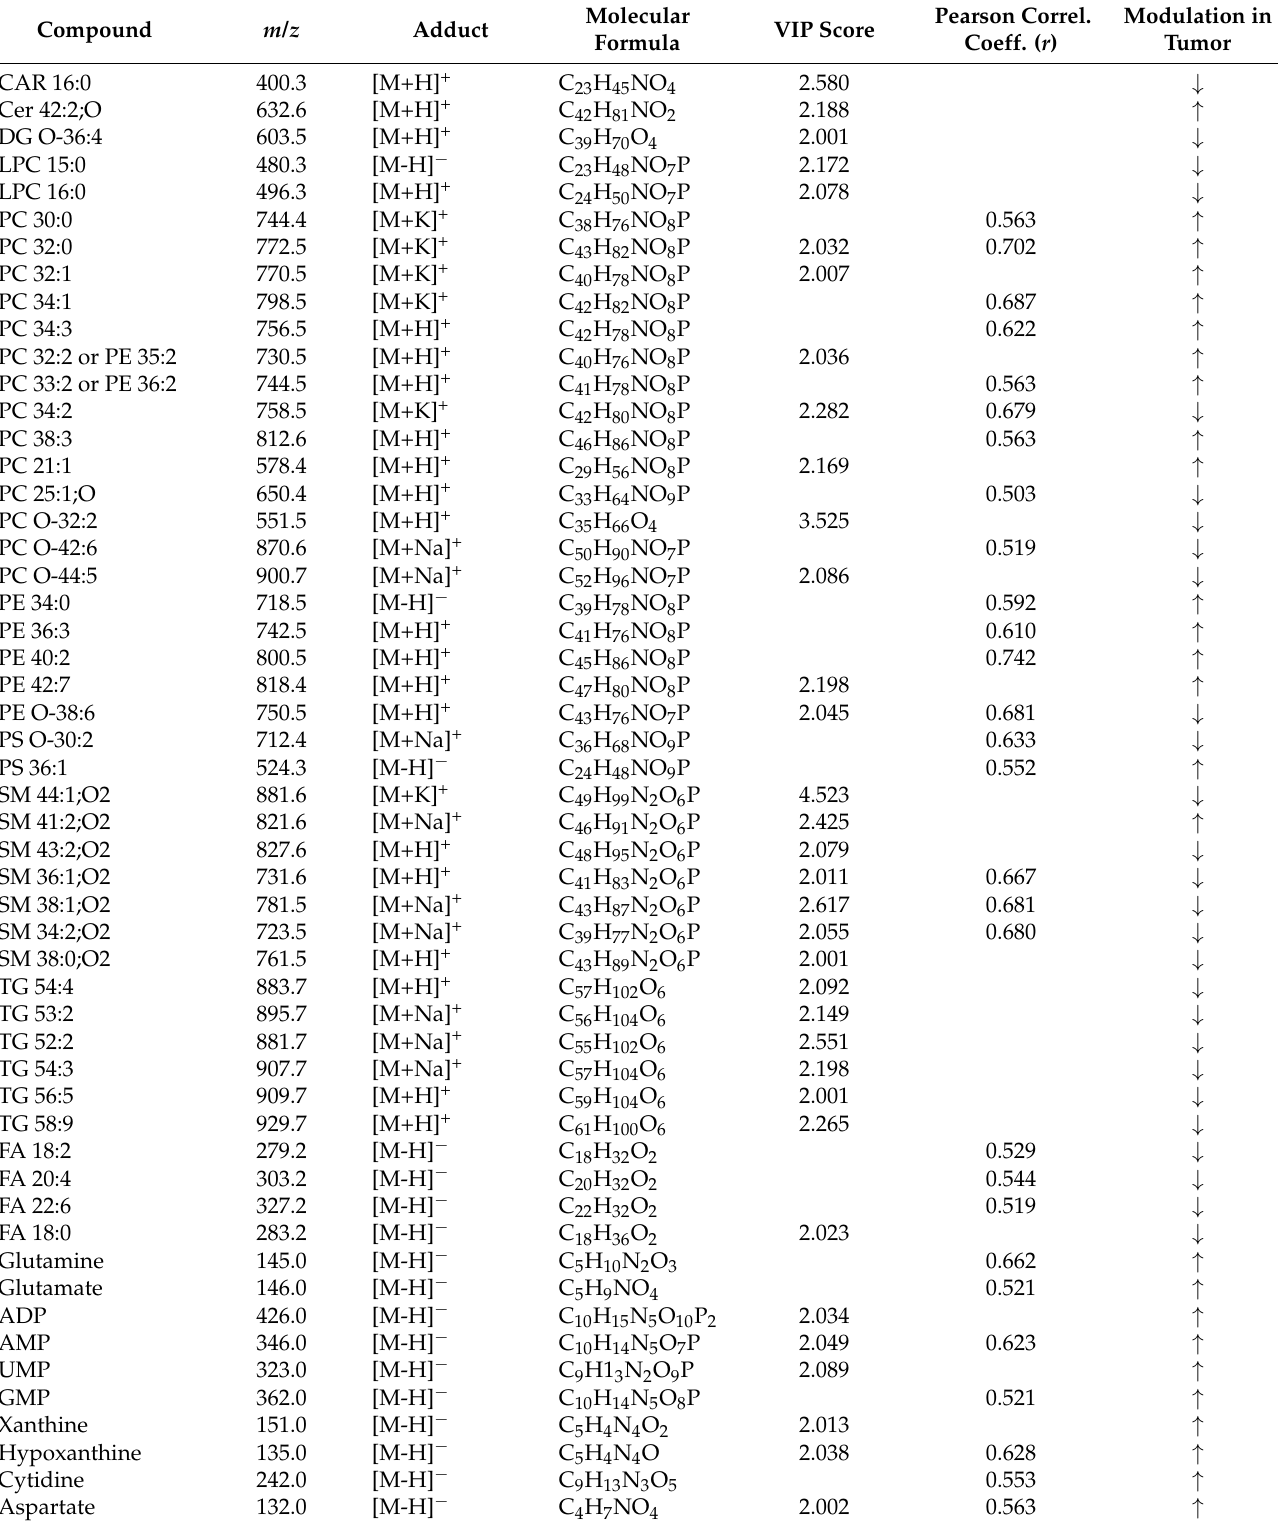
Table 2. List of statistically relevant annotated metabolites derived from PLS-DA and/or a spatial seg- mentation analysis. Detailed parameters for the tentative annotation are reported in Tables S2 and S3. ( ↑ , Up-regulation in Tumor; ↓ , Down-regulation in